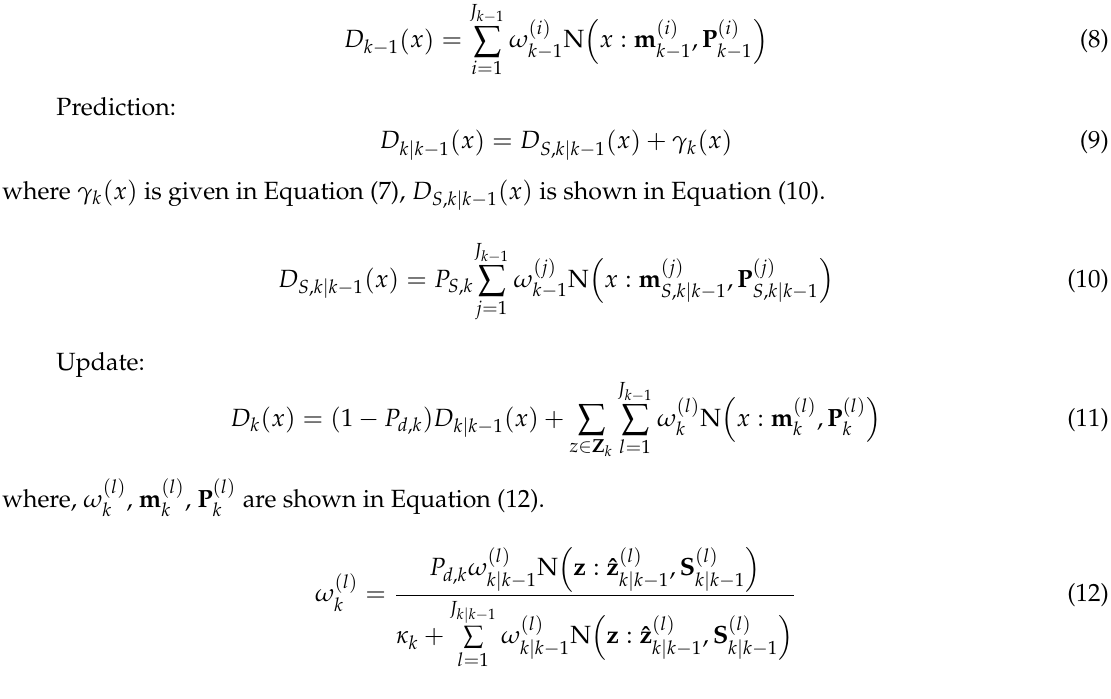
Figure 2. Relationship between Probability Hypothesis Density (PHD) and Gaussian Mixture Probability Hypothesis Density (GM ‐ PHD).